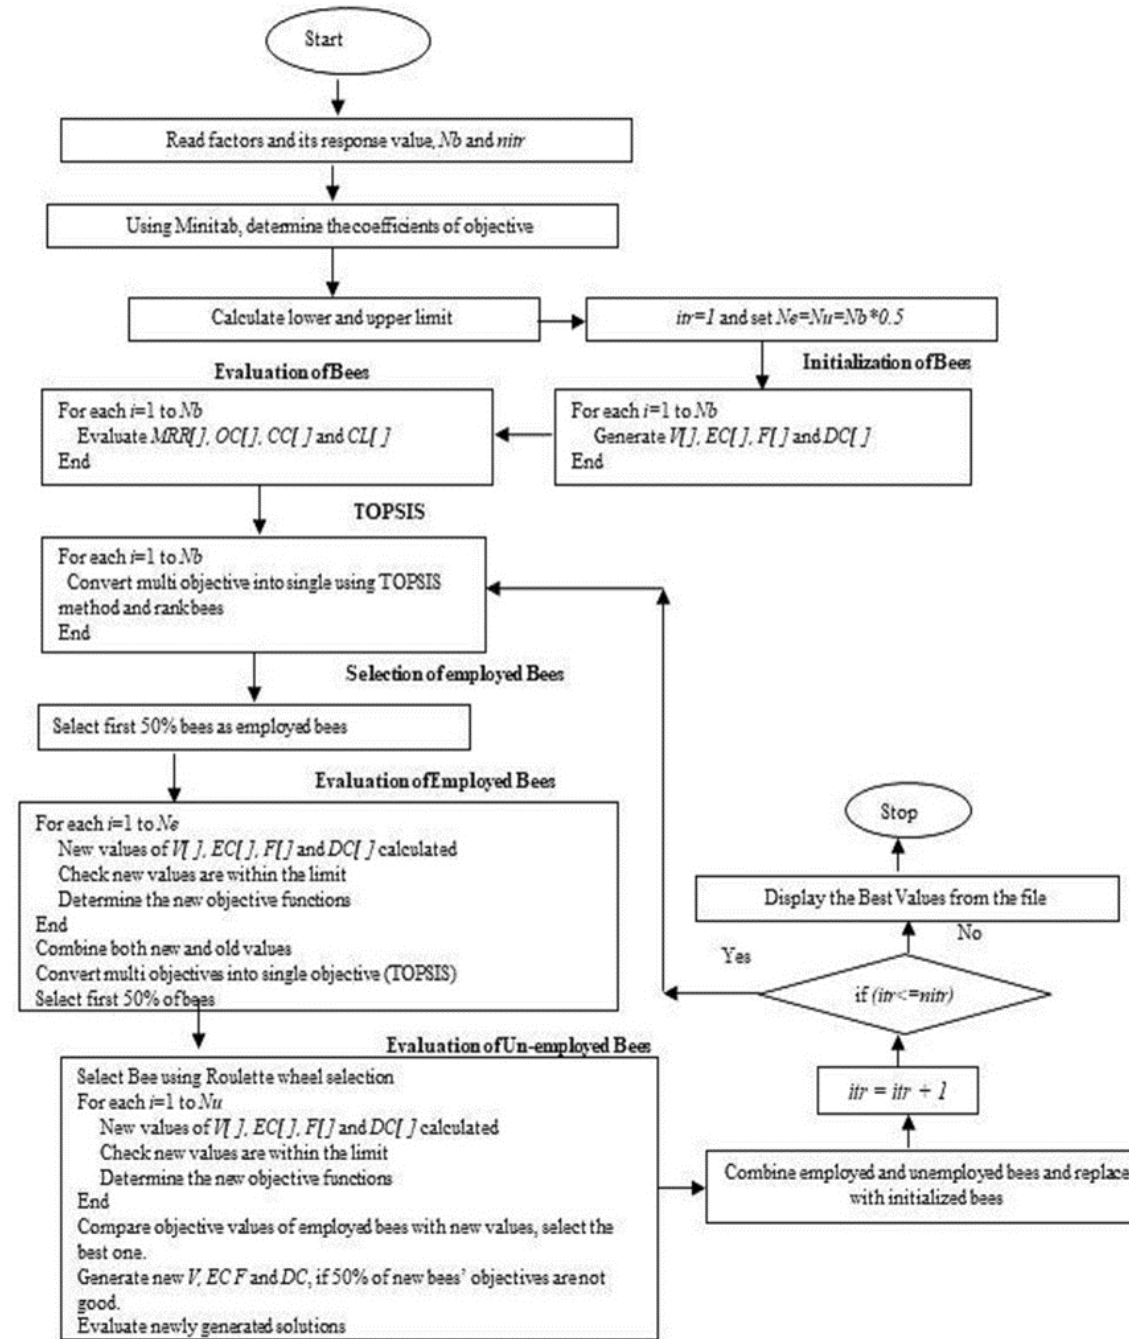
Figure 1. Implementation of ABC algorithm. Table 7. Parameters of ABC algorithm.